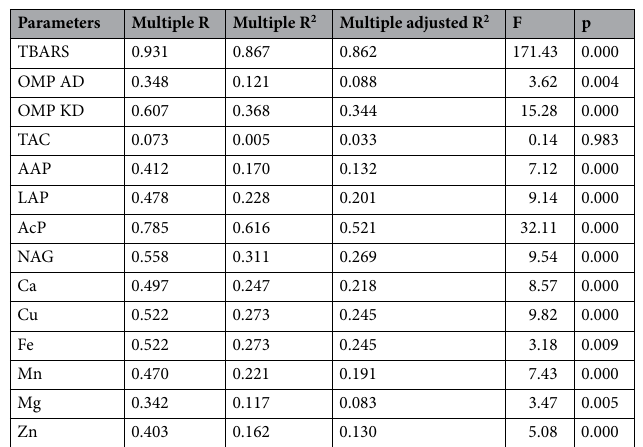
Table 6. SS test of oxidative stress parameters for a full model of the oxidative biomarkers data, lysosomal enzymes and elements in the muscle tissue and SS for residues for the three stages of sea trout development (first-year smolt, spawner, and kelt).